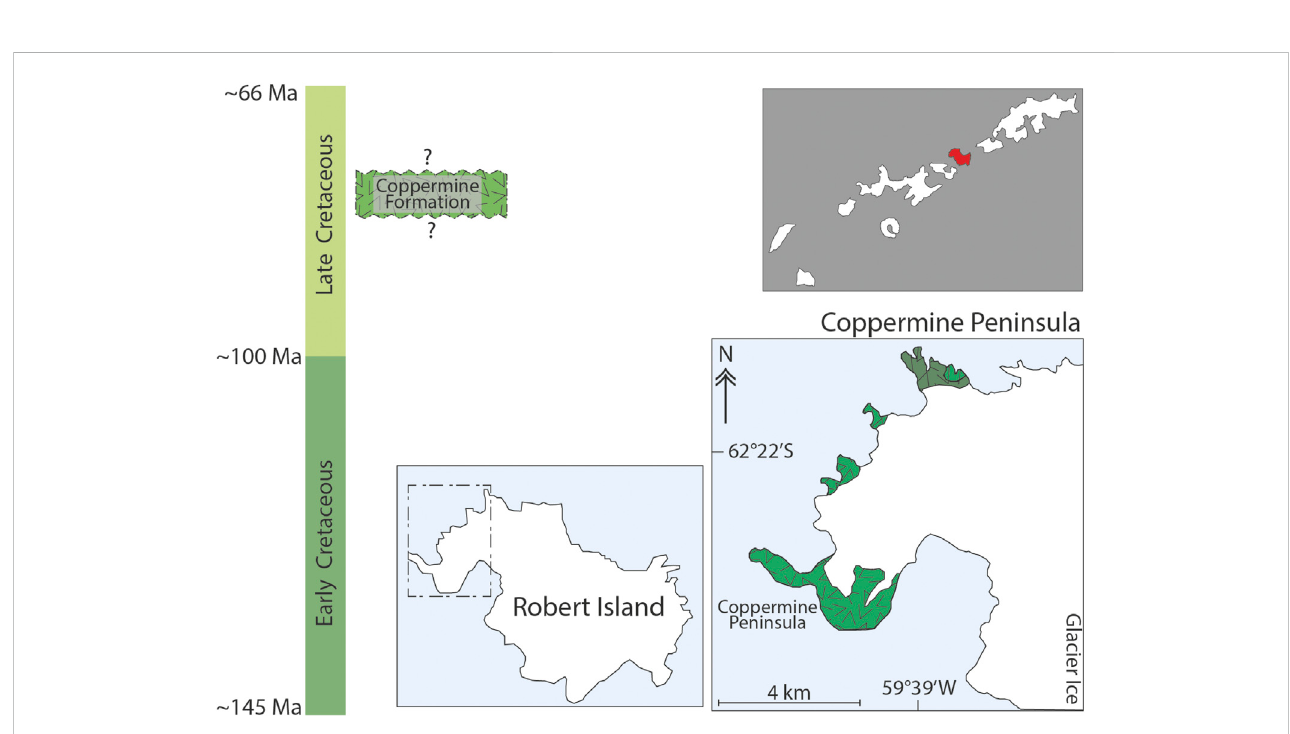
FIGURE 9 Geological map of Coppermine Peninsula, Robert Island, from Machado et al.